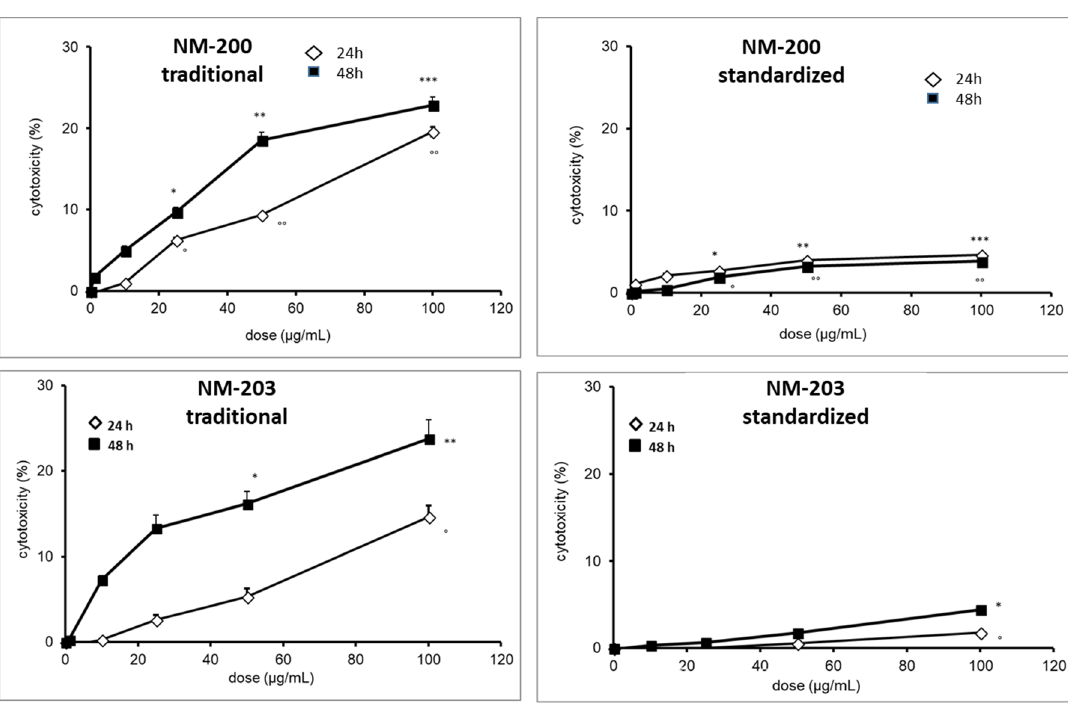
Figure 7. E ff ect of the dispersion protocols on the cytotoxicity of NM-200 and NM-203 towards PMA-activated human monocytes (THP-1) cells measured as lactate dehydrogenase (LDH) leakage. Each measurement was performed in duplicate, and data are presented as means ± SEMs (n = 3 readings): *** p < 0.0001 vs. ctrl; ** p < 0.001 vs. ctrl; * p < 0.01 vs. ctrl; ◦◦ p < 0.001 vs. ctrl; ◦ p < 0.01 vs.